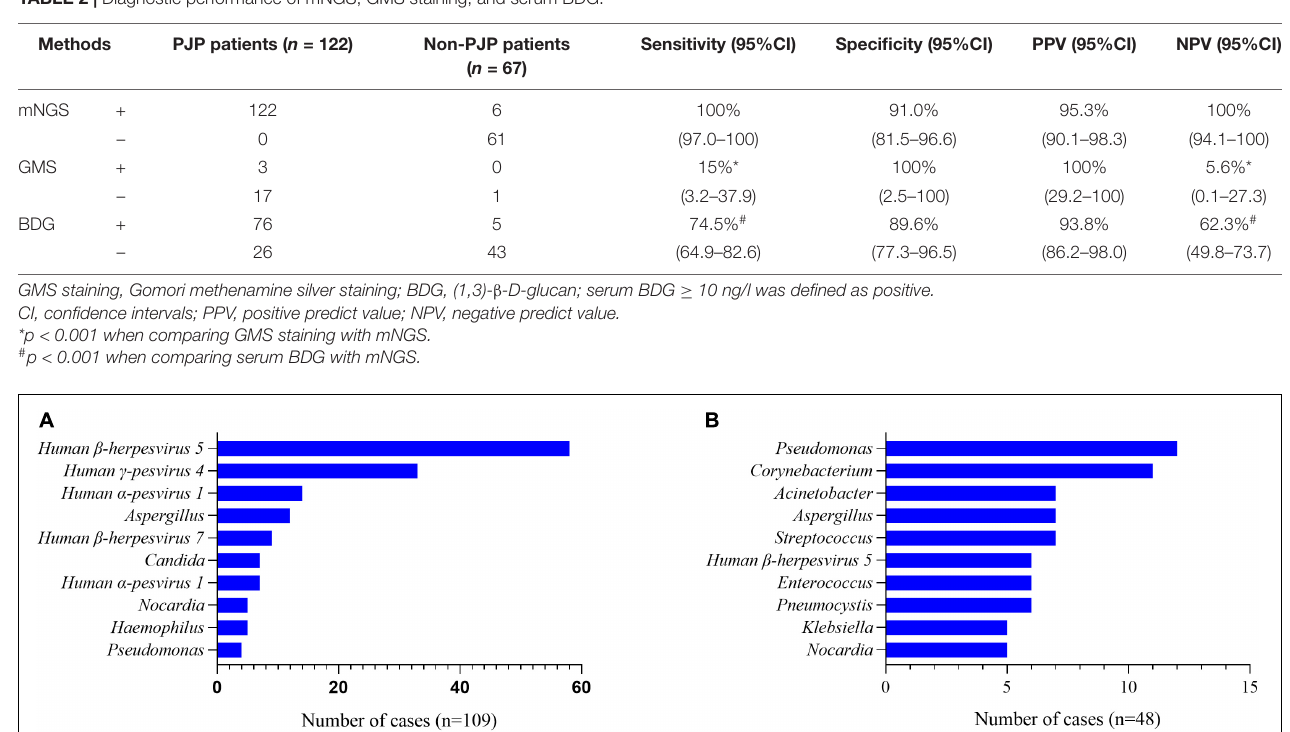
TABLE 2 | Diagnostic performance of mNGS, GMS staining, and serum BDG.